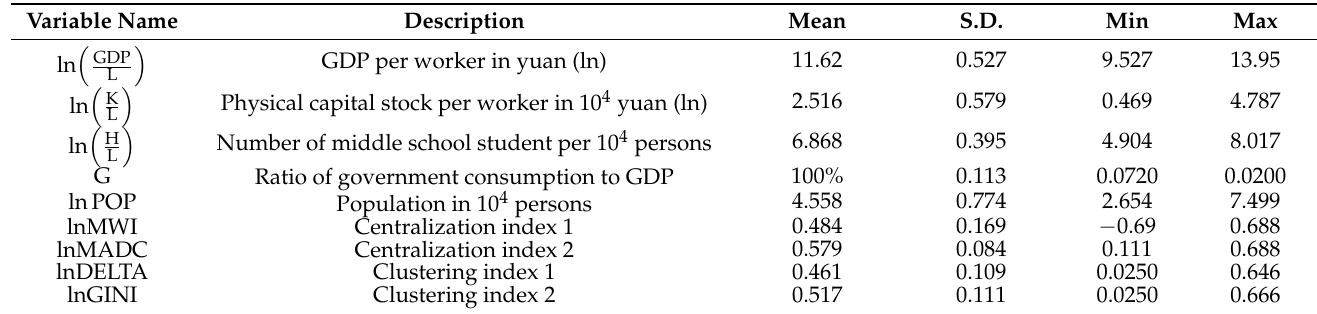
Table 2. Descriptive statistics of the